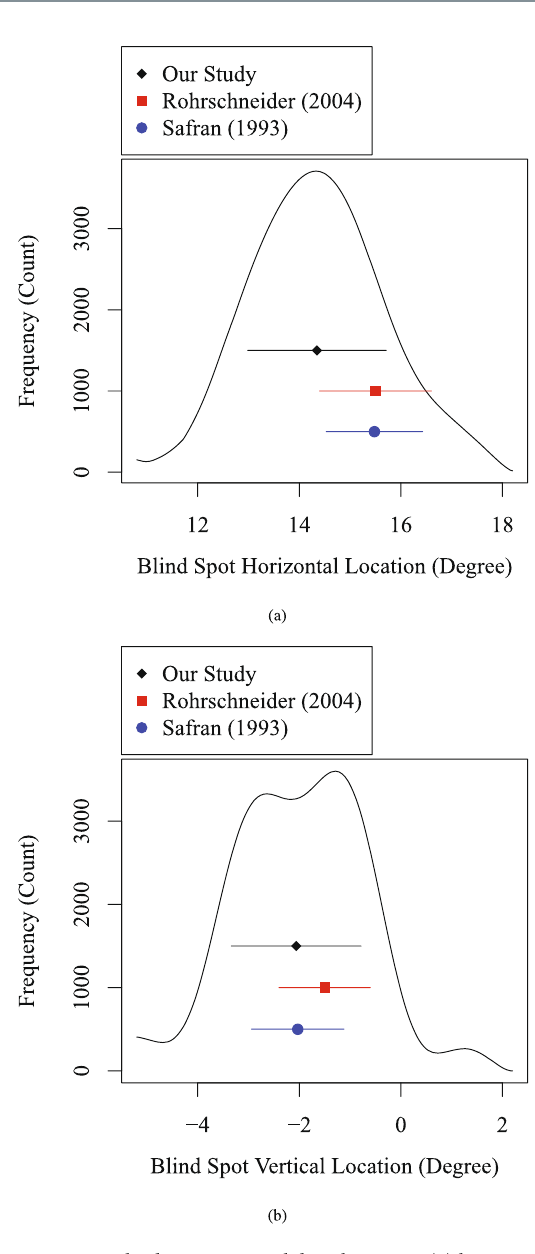
Figure 2. Blind spot marginal distribution in ( a ) horizontal direction and ( b ) vertical direction from the current study and previous studies in literature. Black diamond and line denote the mean and standard deviation of NBSL calculated in our work, blue dot and line denote the mean and standard deviation of NBSL in the work by Safran et al . 20 , and red square and line denote the mean and standard deviation of the optic disc location relative to fovea in the work by Rohrschneider 21